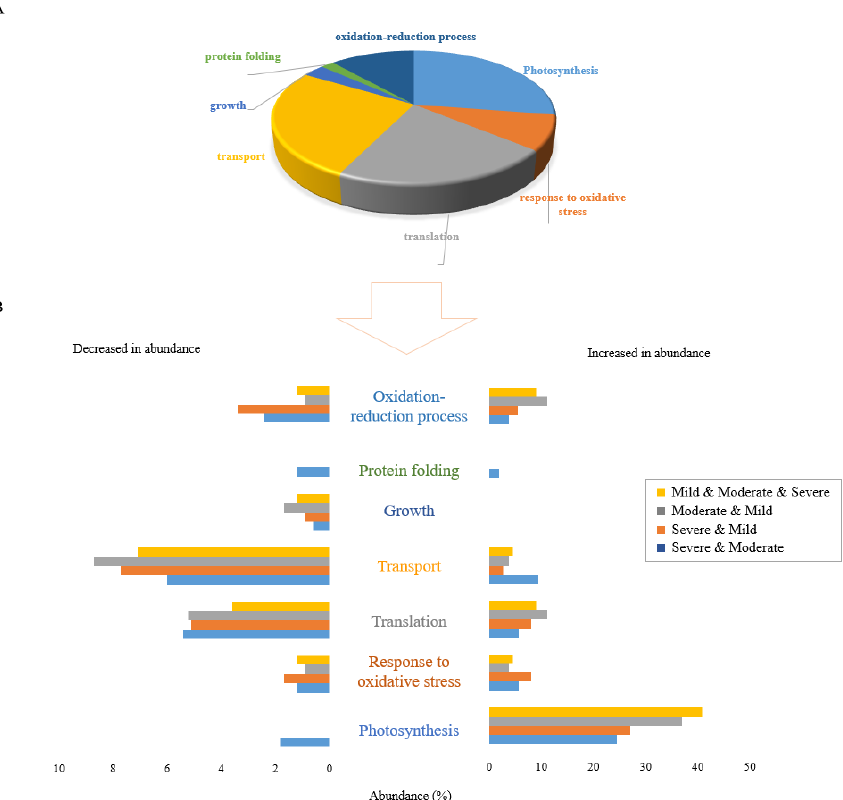
Figure 2. Functional classification of 106 differentially accumulated proteins in response to all 3 drought stress levels. ( A ) The pie chart shows the percentage of different biological functions of common proteins significantly changed in abundance in response to all three drought stress levels. ( B ) The bar graph shows the percentage abundance of proteins in 7 functional categories that were significantly altered in response to drought stress at divergent levels. Distinct colours represent proteins significantly changed in common between stresses: severe and moderate drought (blue), severe and mild drought (orange), moderate and mild drought (grey), and overlapped between all three drought stress levels (yellow).